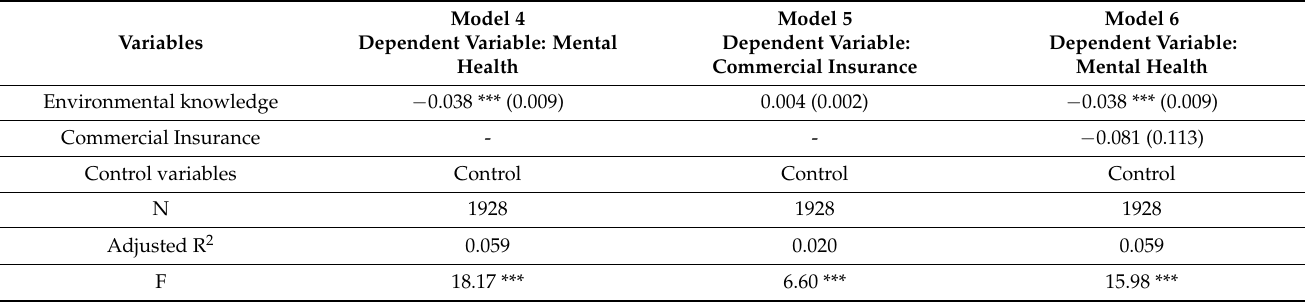
Table A2. Mediation test of commercial insurance on EK and women’s mental